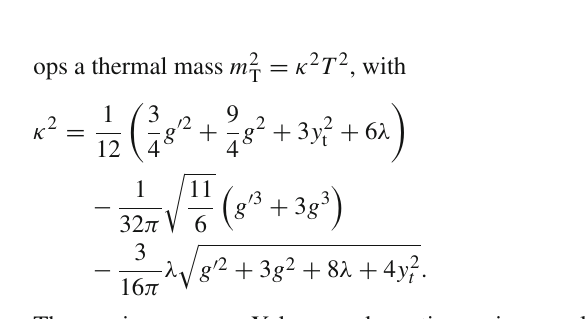
Fig. 1 The quantities F 1 and F 2 , that determine the bubble mass δ M tot , as a function of the black-hole radius. All quantities in units of the value of the Higgs field h max at the maximum of the